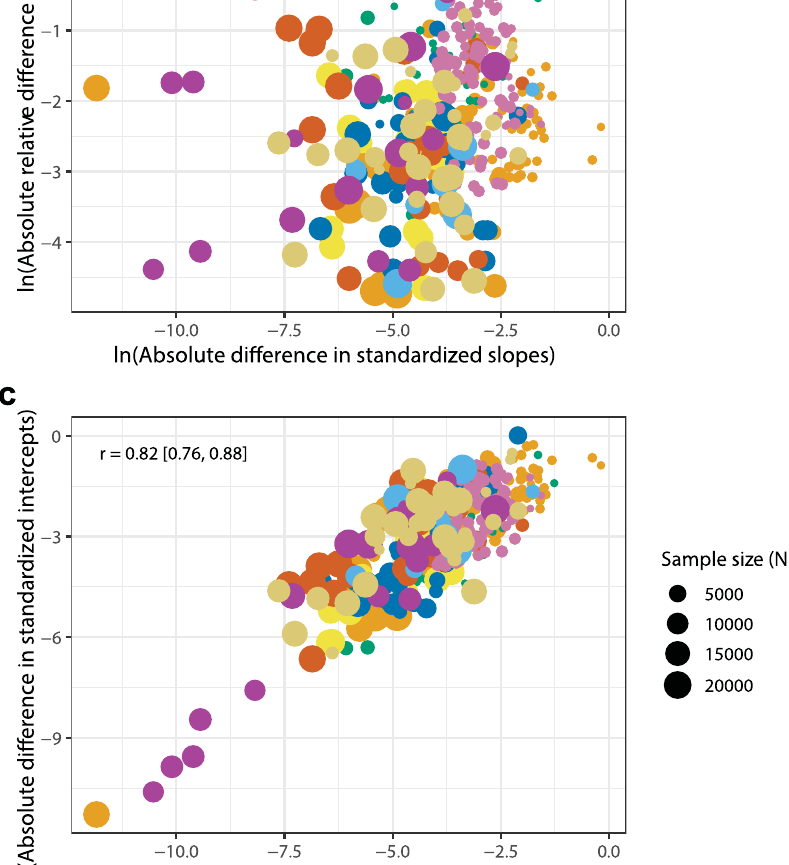
Fig. 4 | Bivariate ordinations of log absolute difference between males and females for allometric variables. Plots show biological traits collated into nine functional groups (i.e., trait types, represented as different circle colours). Indivi- dual effect sizes (circles) are scaled by their sample size (N), the number of mice